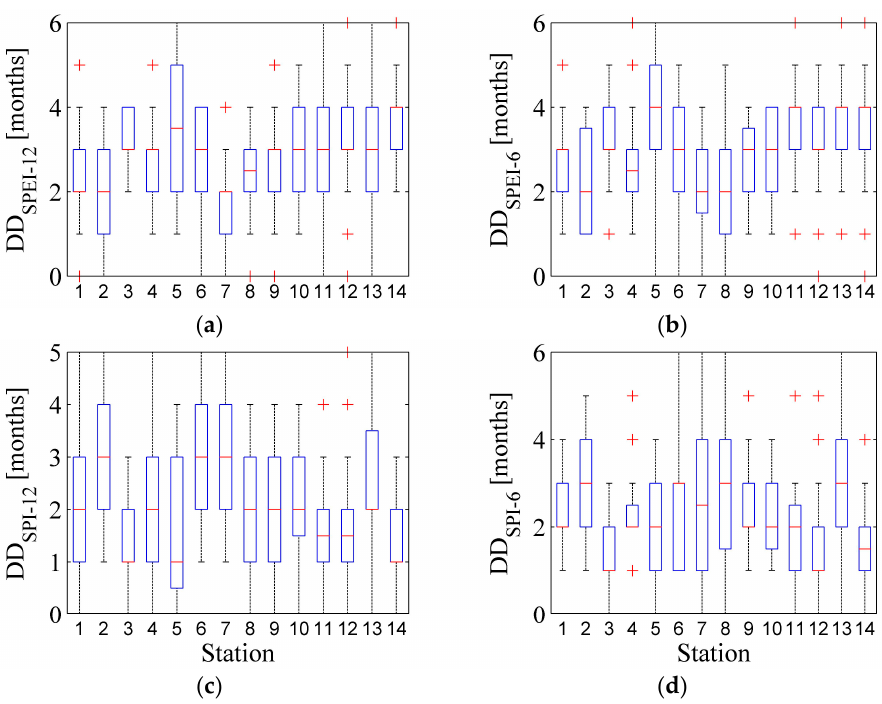
Figure 7. Drought Duration (DD) across the Free State and North West Provinces. ( a ) Drought duration computed using SPEI 12 values; ( b ) drought duration computed using SPEI 6 values; ( c ) drought duration computed using SPI 12 values and ( d ) drought duration computed using SPI 6 values.